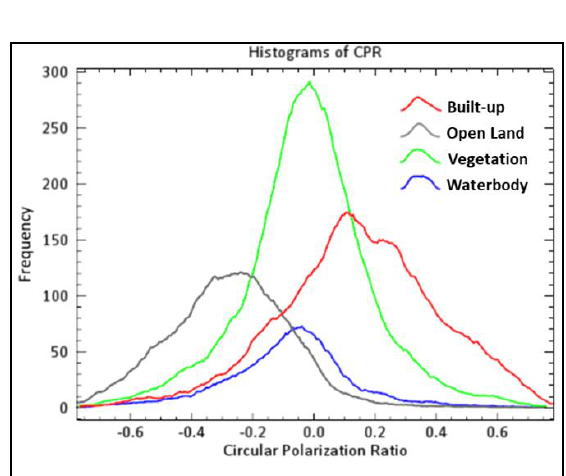
Figure 2 : Histogram of CPR in different Land cover classes From the fig 2, the variation of CPR for different land